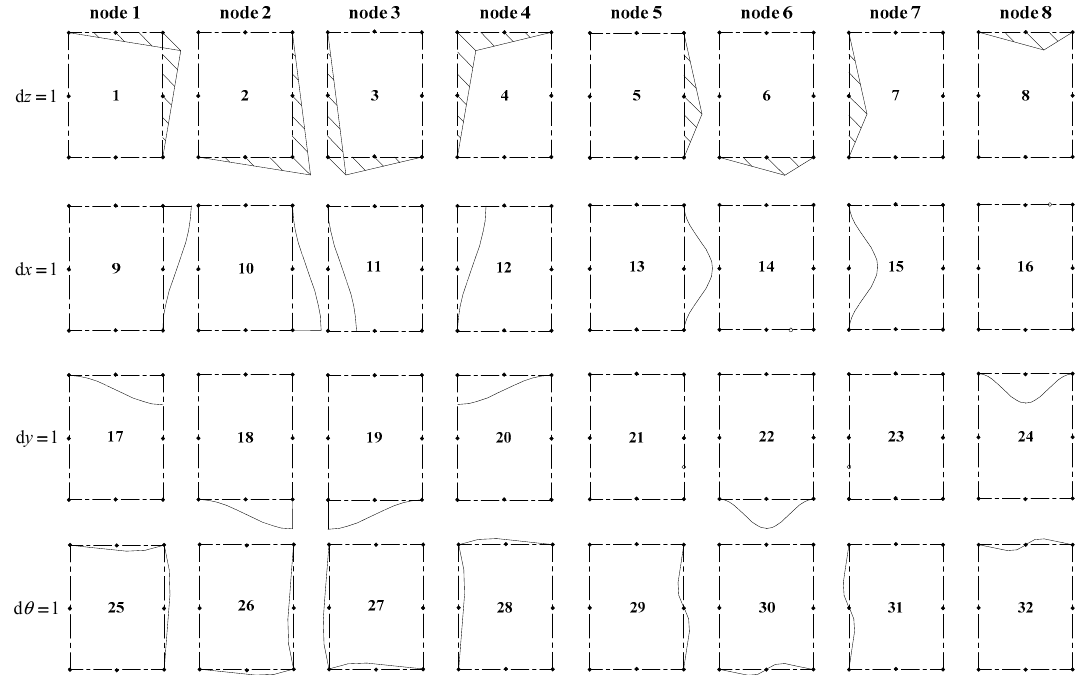
Figure 3. Basis deformation modes of a thin-walled, rectangular, hollow cross-section with eight discretization nodes.